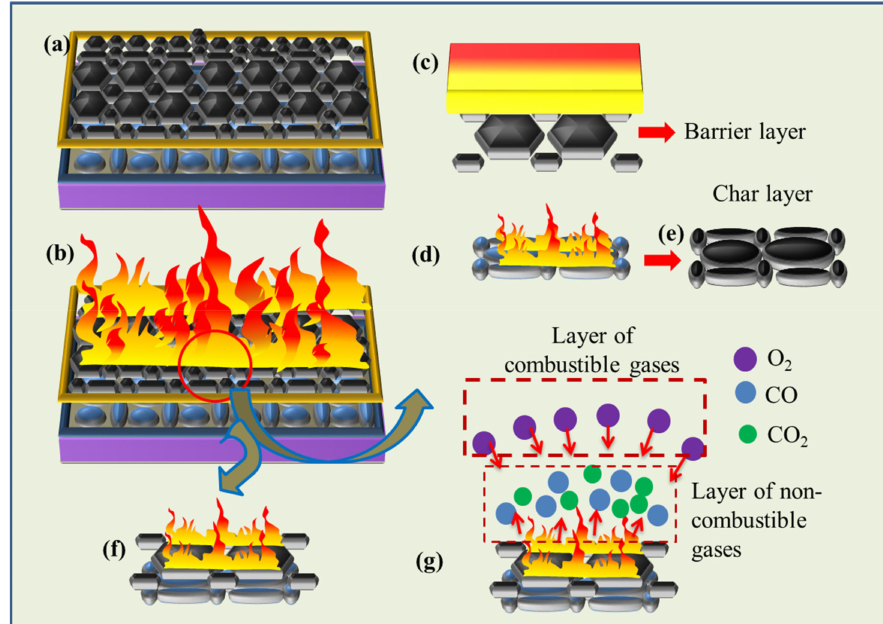
Figure 9. Threefold mechanisms offered by coatings to protect the substrates.